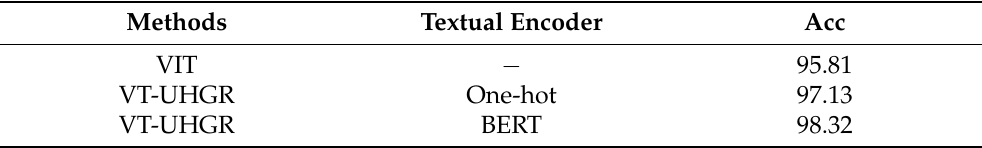
Table 4. Impact of different textual encoders on VT-UHGR performance on the CADDY dataset. Methods